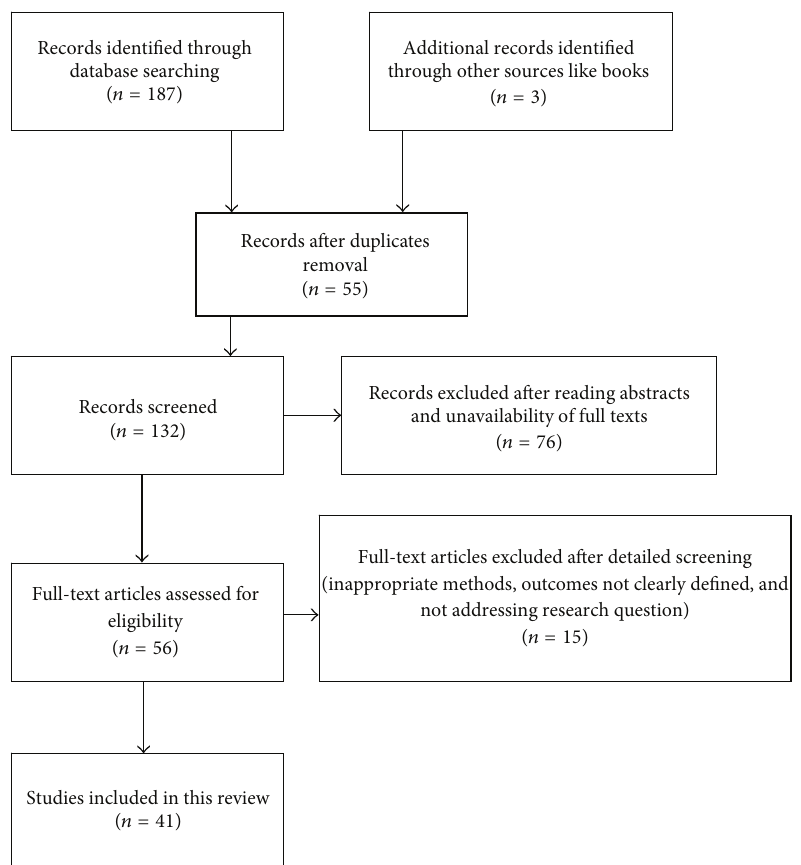
Figure 1: Flow diagram of literature